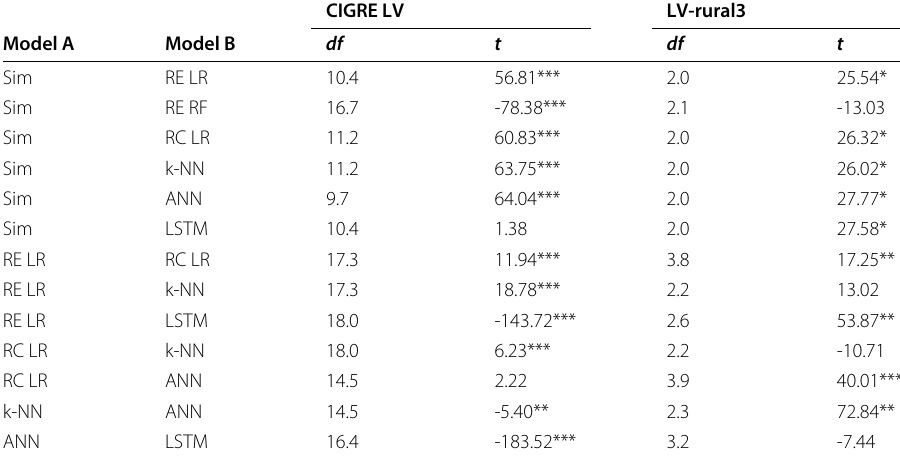
Table 1 Results from the independent samples Welch’s t-test for both grids. Shown are the t-statistics and the corresponding degree of freedom ( df ). Reported p-values were Bonferroni-corrected. Combinations missing in this table were significant with p < .001 for both grids CIGRE LV